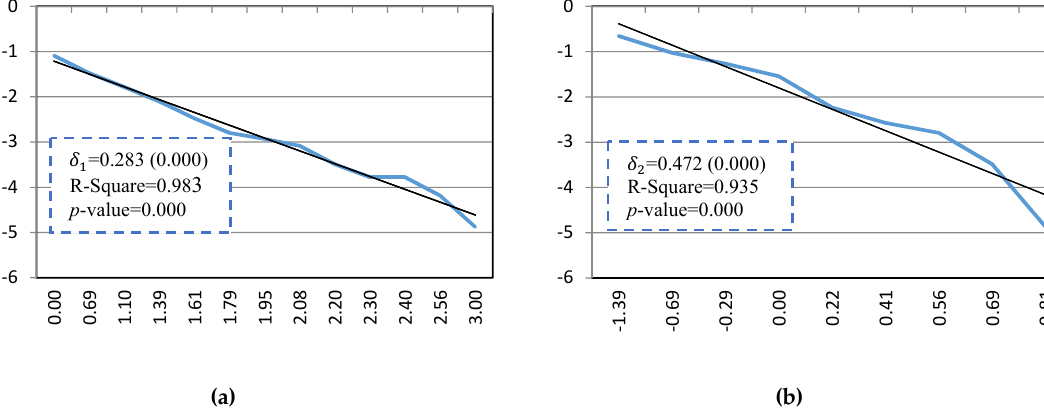
Figure 6. ( a ) Cumulative distribution of s j ; and ( b ) cumulative distribution of H i